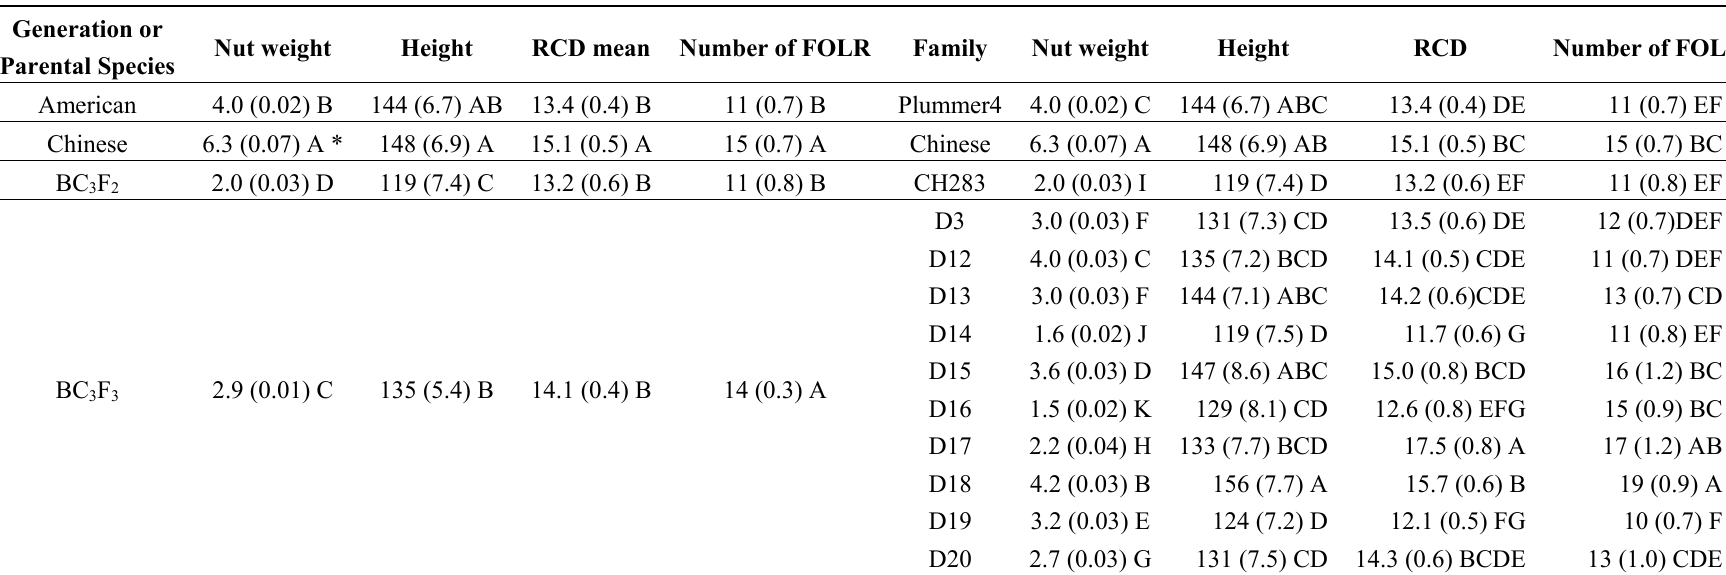
Table 4. Least squares means differences in nut weight ( n = 2691), height ( n = 1741), root-collar diameter (RCD) ( n = 1741), and number of first-order lateral roots (FOLR) ( n = 1589) for each breeding generation/parental species and genetic family. Generation